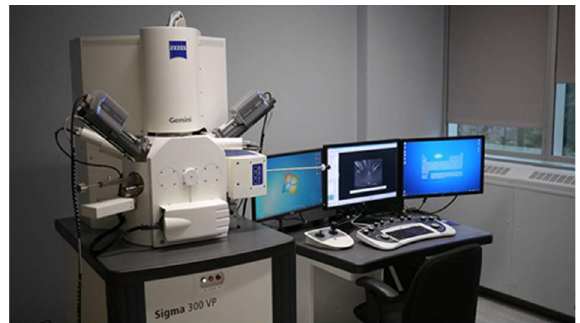
Figure 9. Zeiss Sigma 300.